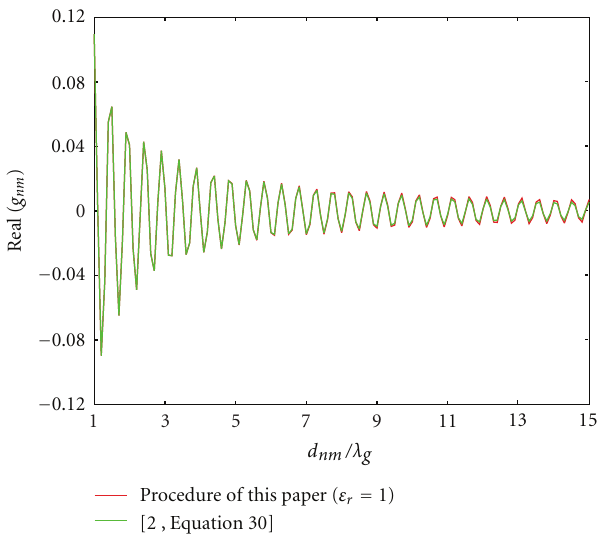
Figure 2: Real part of the mutual coupling coe ffi cient g nm , θ = 45 ◦